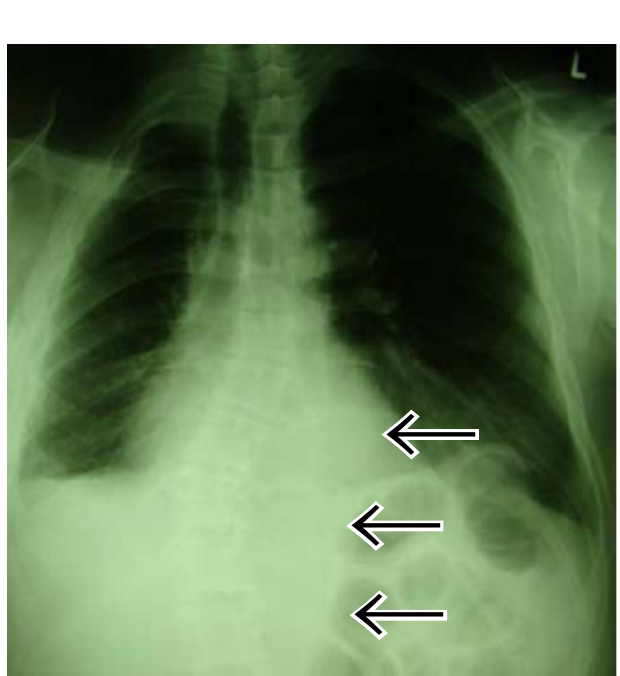
Fig. 9b. Frontal chest X-ray demonstrates dextroscoliosis of the lower thoracic spine associated with large soft-tissue left para-vertebral mass, erosion and thinning of the 10th, 11th and 12th ribs on the left, and left lateral vertebral body